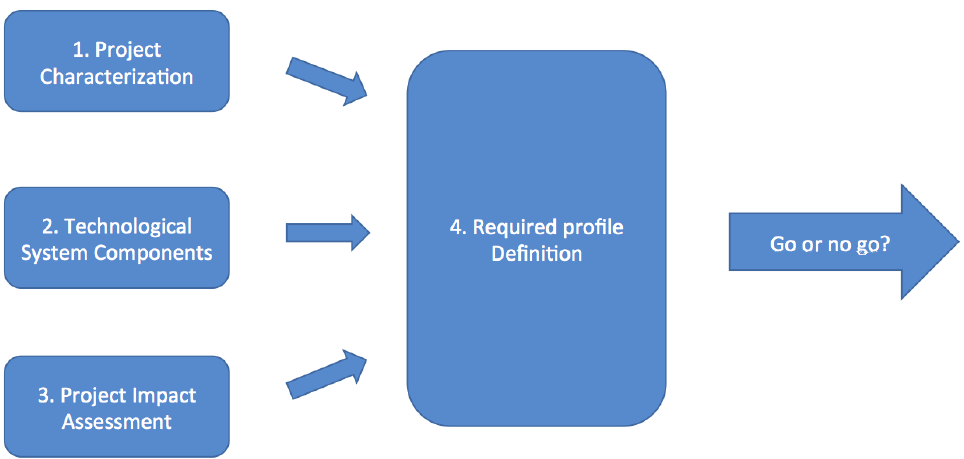
Figure 2. Maturity assessment methodology of the company’s technological system in relation to innovation project profile required.